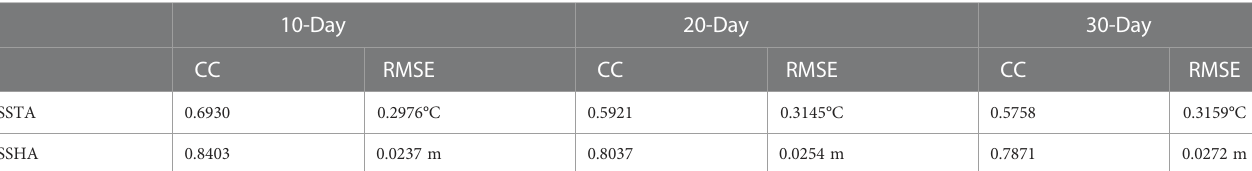
TABLE 2 The experimental results of 10-, 20-, and 30-day